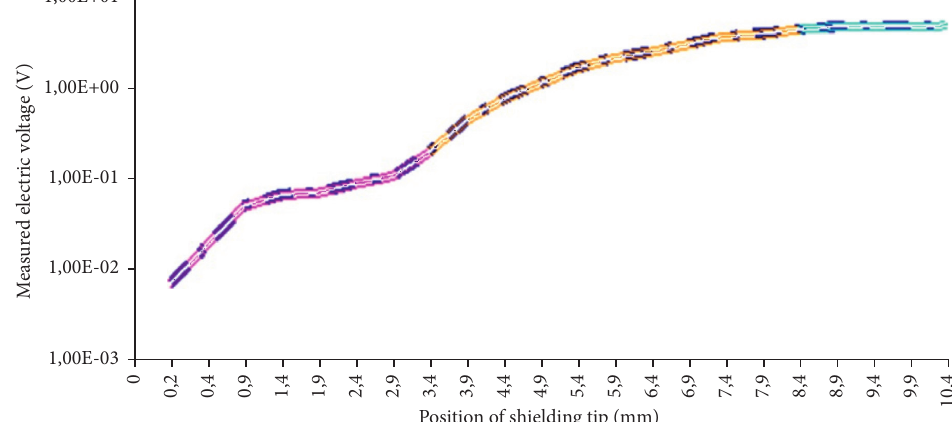
Figure 7: Graphical plot of the arithmetic mean of electric voltage to the position of the shielding tip in a logarithmic scale.